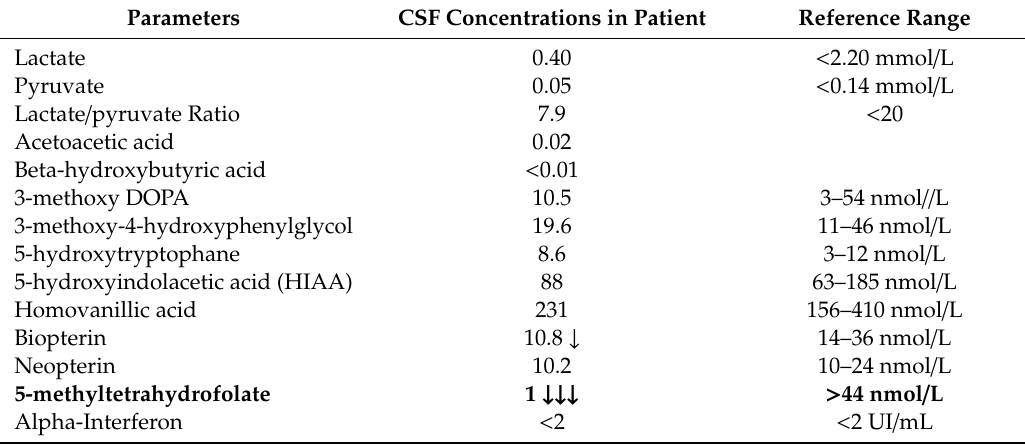
Table 1. Metabolic profile of cerebrospinal fluid (CSF) before treatment.